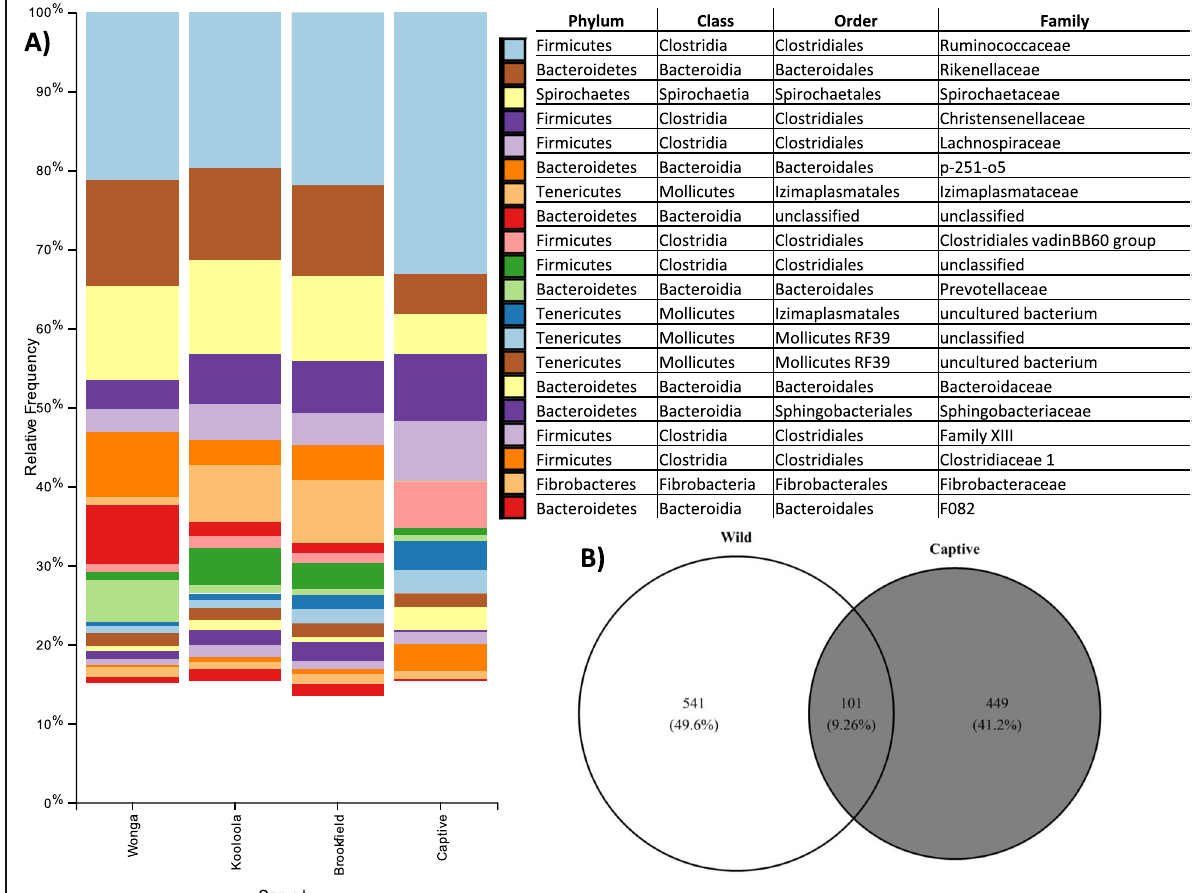
Fig. 3 Family-level microbial taxonomic bar charts of the 20 most abundant families collapsed by population, ordered from most abundant family (top) to least (bottom) ( a ). Only the top 20 most abundant families are displayed for clarity. Venn diagram of ASVs found uniquely or shared between captive and wild individuals ( b ). The size and overlap of regions is weighted by the number of ASVs with the percentage of total ASVs listed for each region. Wonga (intact habitat), Kooloola and Brookfield (degraded